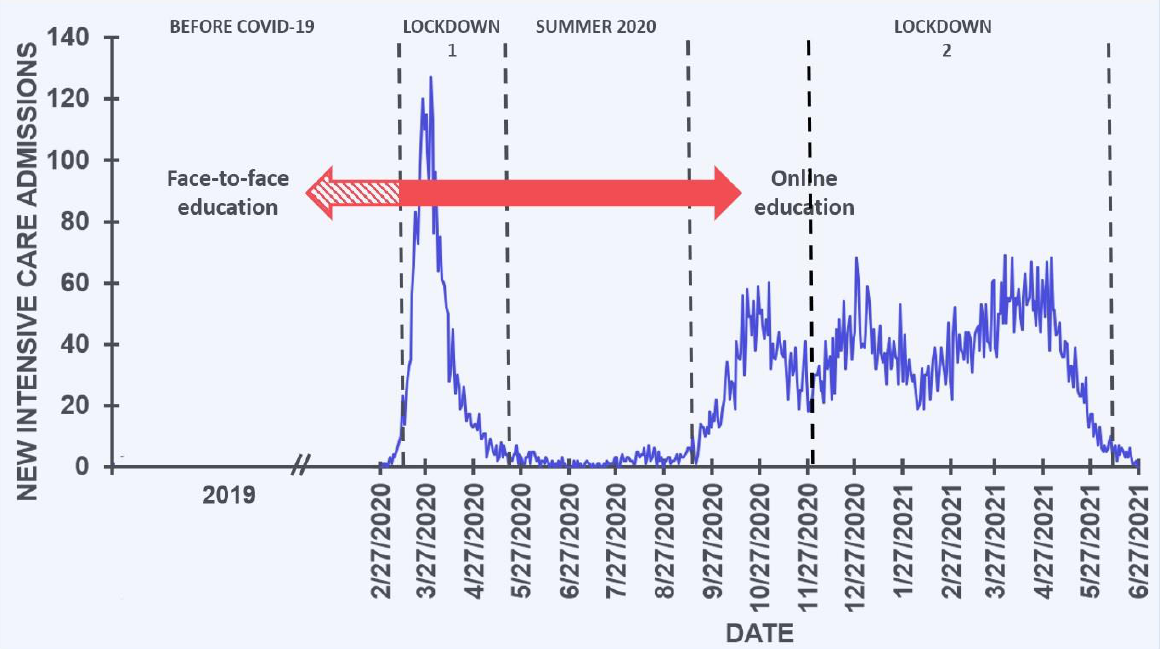
Figure 1. Number of COVID-19 intensive care patients in the Netherlands and related lockdowns. During the lockdown periods, bars and restaurants were closed, and universities switched from face-to-face education to online education. The blue line represents the number of new intensive care admissions. The red arrows represent the periods of predominantly face-to-face education (before mid-March 2020) and predominantly online education (after mid-March 2020). Dashed lines segregate the lockdown and non-lockdown periods. Data from reference [1].